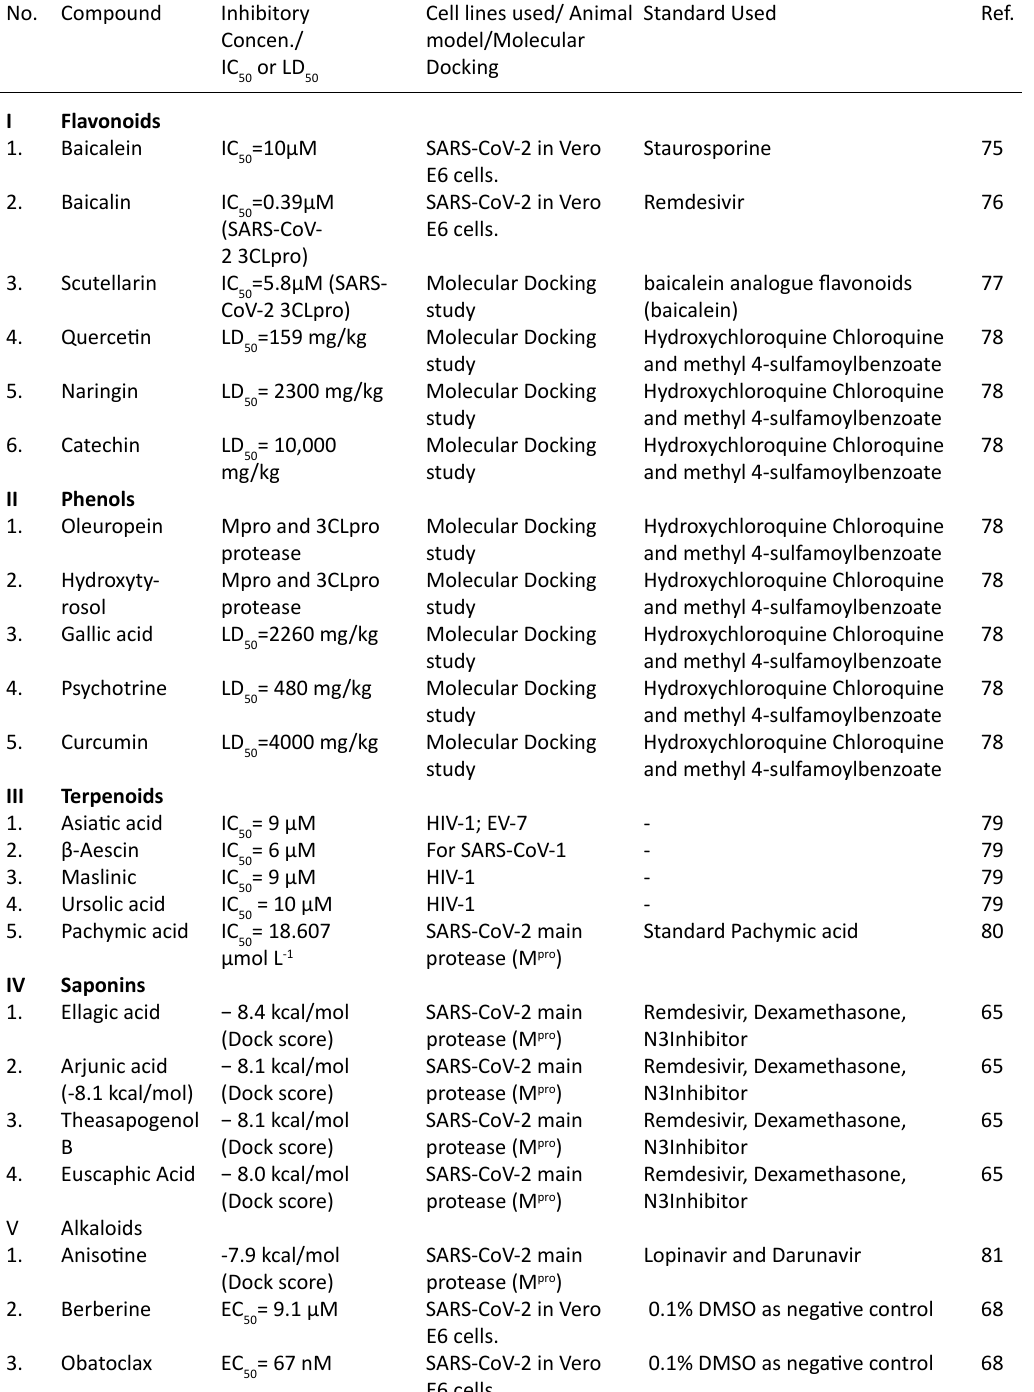
Table 1. List of Phytochemicals and their inhibitory effect against SARS-CoV-2 No. Compound Inhibitory Cell lines used/ Animal Standard Used